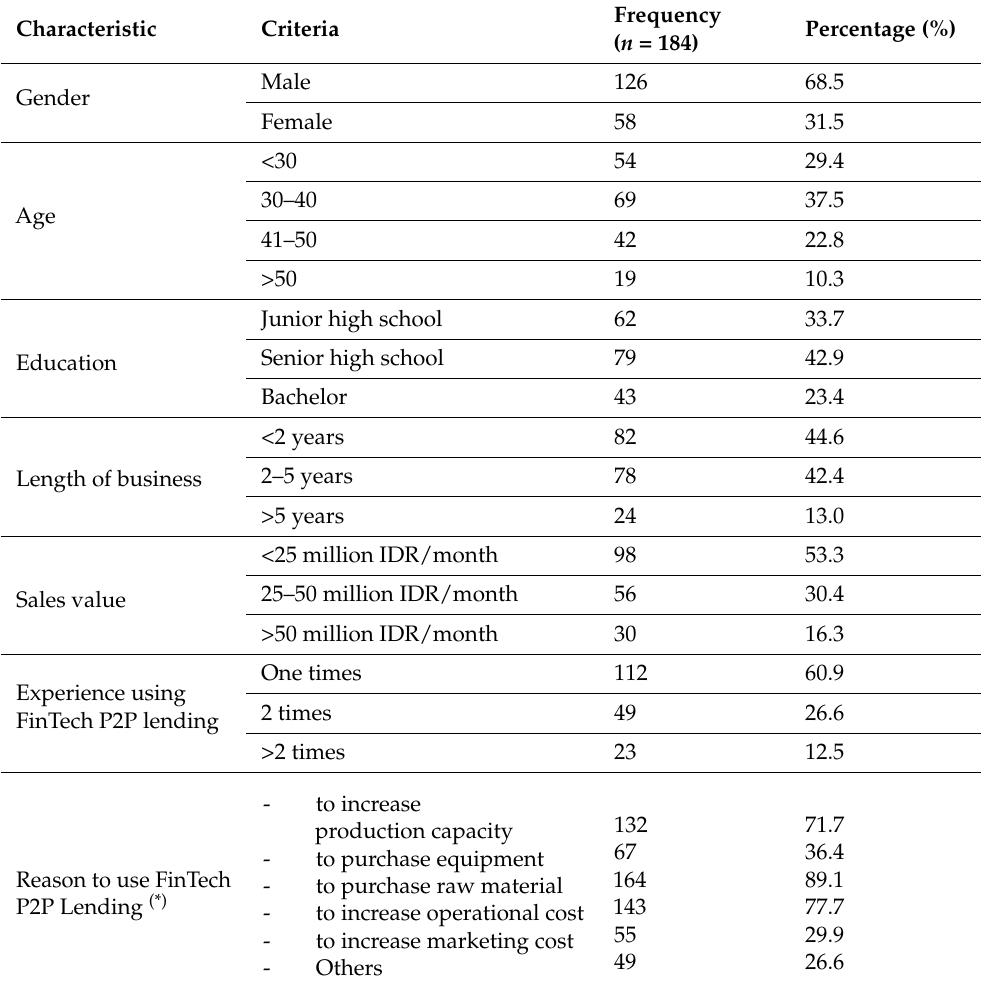
Table 1. Characteristic of